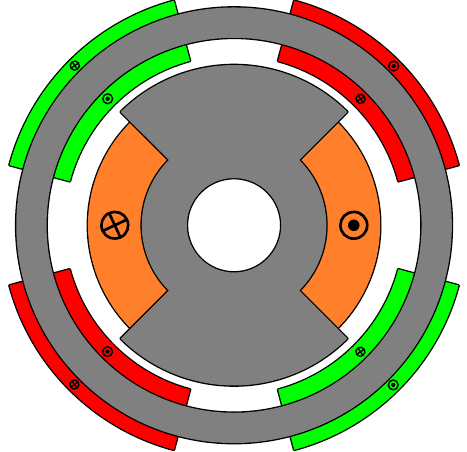
Figure 28. Toroidal winding slotless